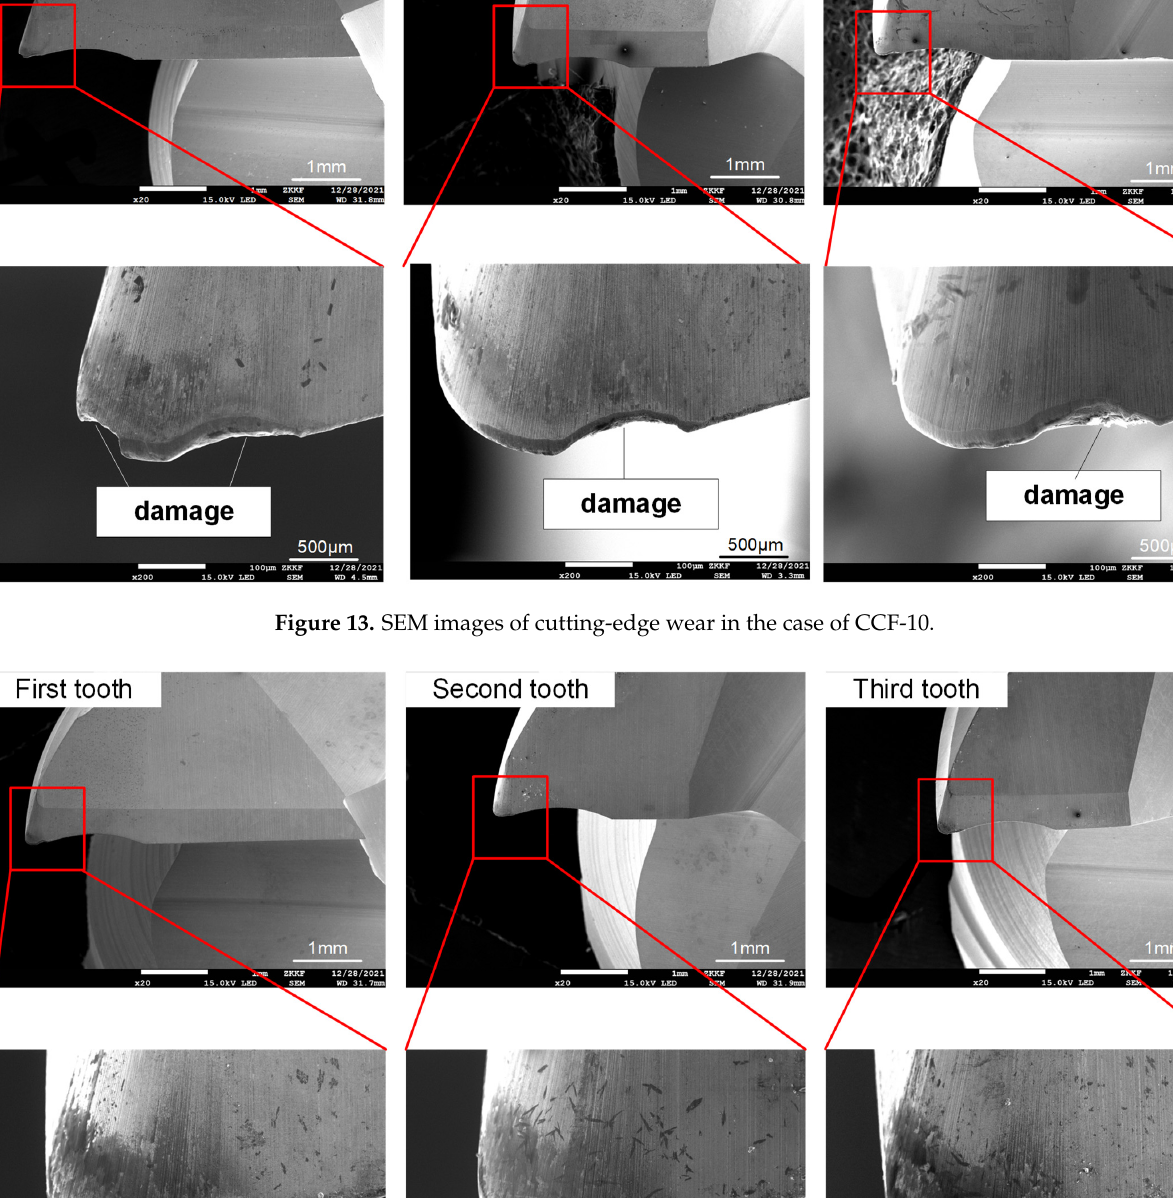
Figure 12. SEM images of wear surface of whole tool under two cutting fluid conditions.